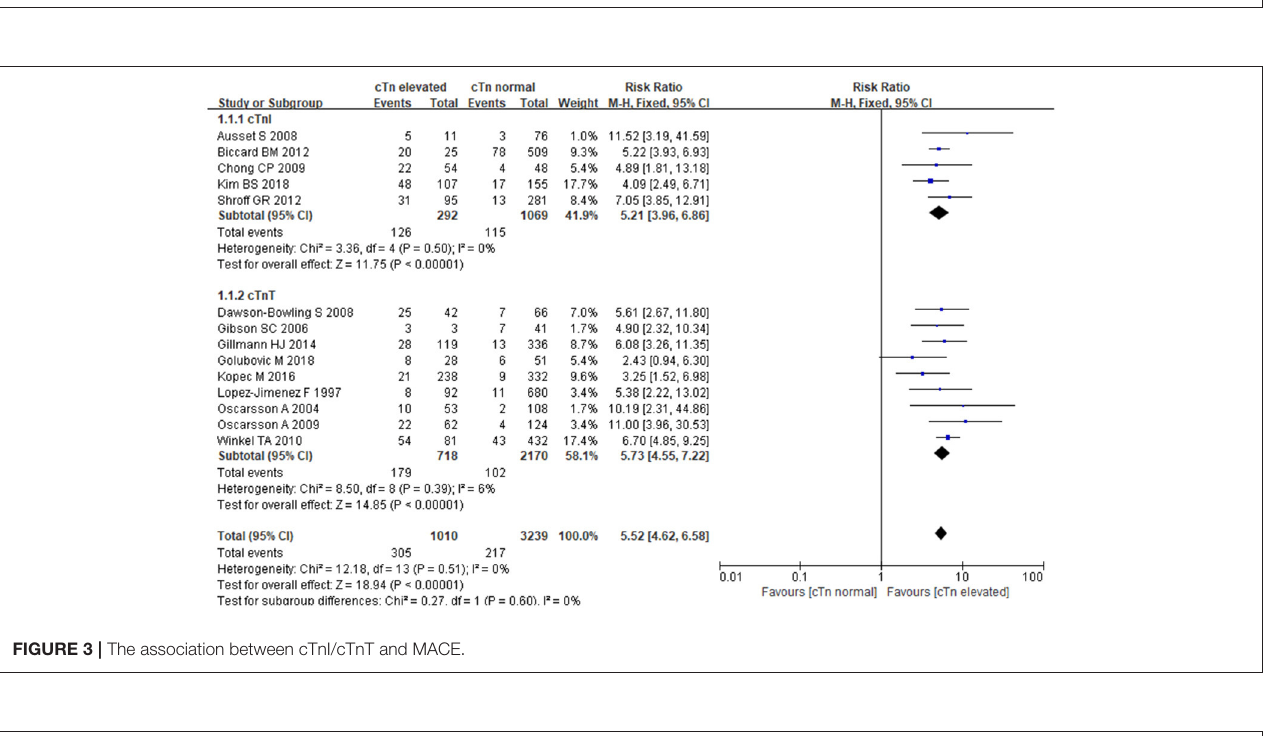
FIGURE 2 | The association between BNP/NT-proBNP and MACE.